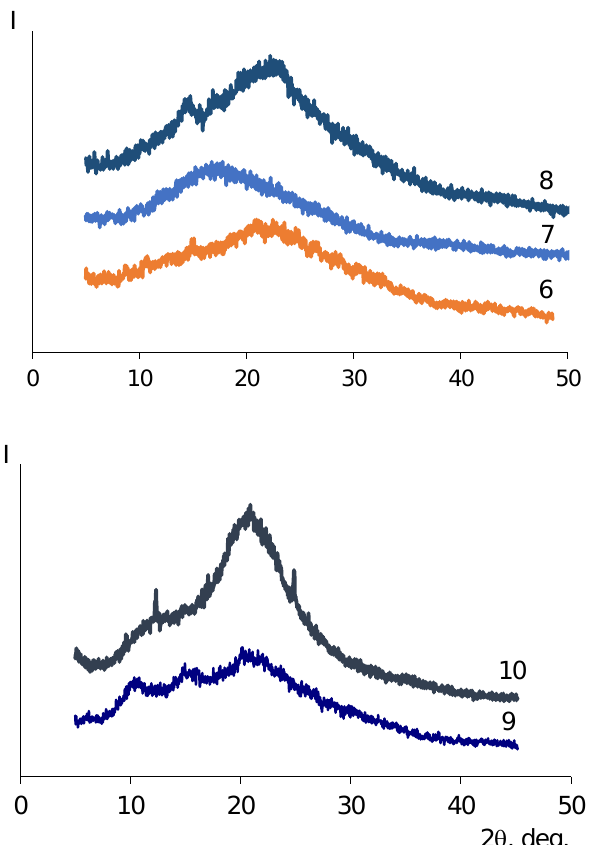
Figure 2. X-ray di ff raction patterns: polyethylene oxide (PEO)-film (1), PEO-nonwoven (2), Figure 2. X-ray diffraction patterns: polyethylene oxide (PEO)-film (1), PEO-nonwoven (2), CS-film